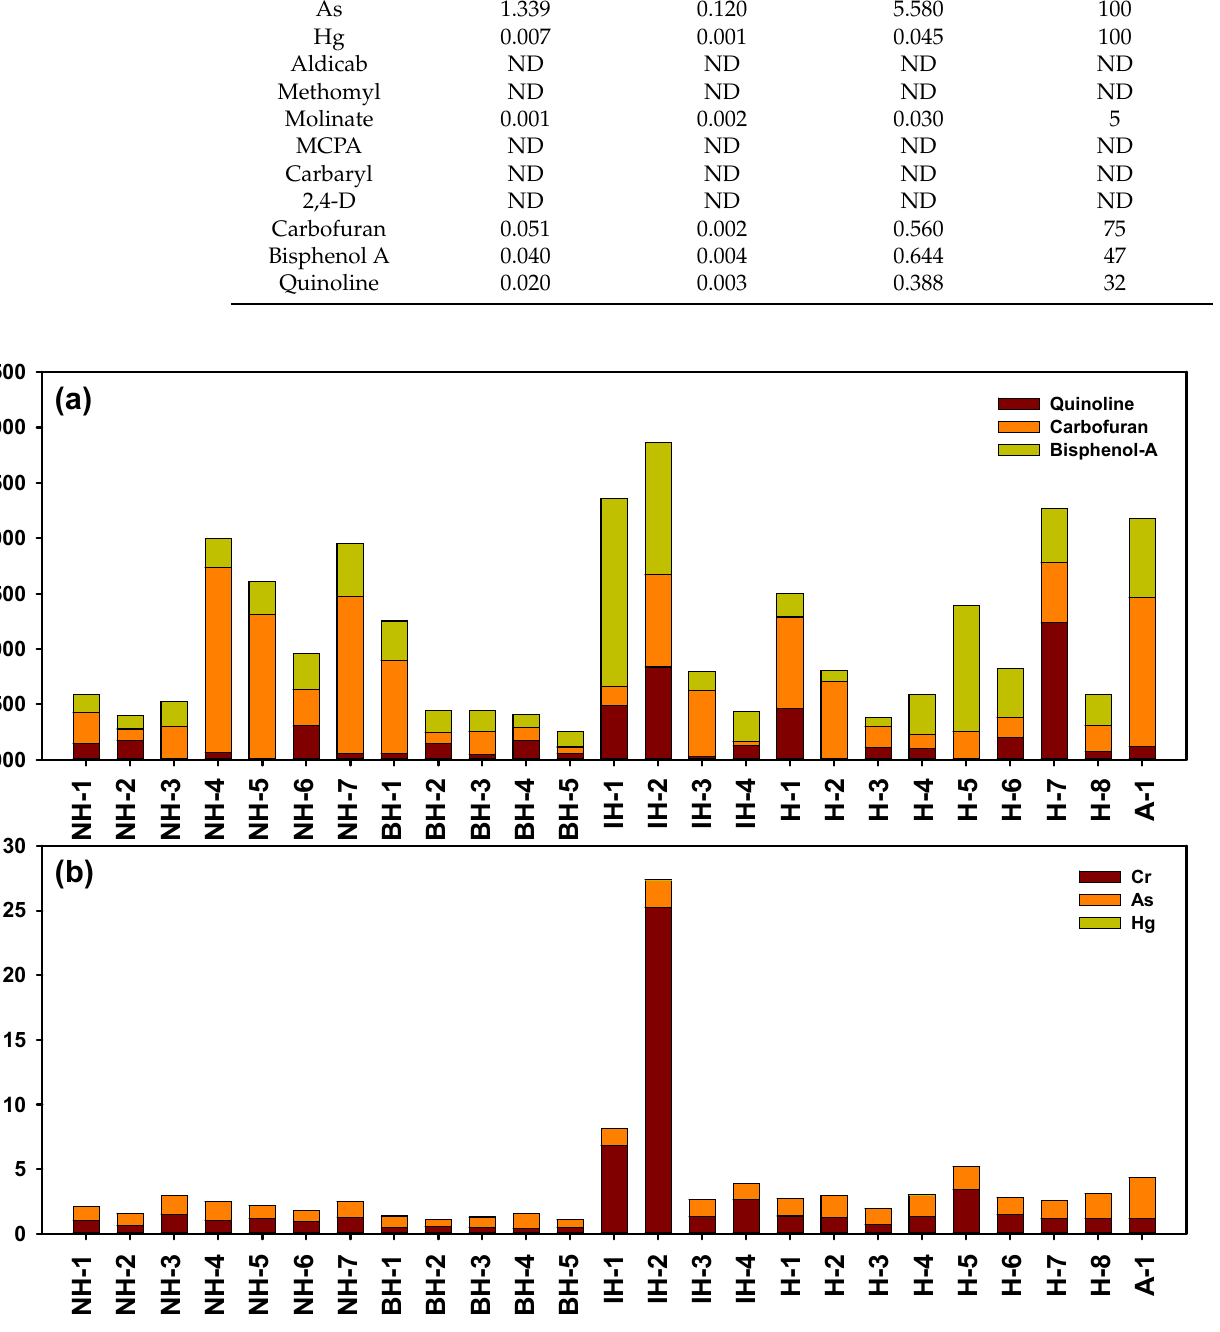
Figure 2. Mean concentration of ( a ) heavy metals and ( b ) organic compounds in the Han River watershed. In addition, in the five groups according to the sampling location, the concentration of the organic compounds was in the order IH > A > NH > H > BH, and that of the heavy metals showed a trend of IH > A > H > NH > BH, as presented in Figure 3. Both the organic compounds and heavy metals were detected at the highest concentration at IH-2,